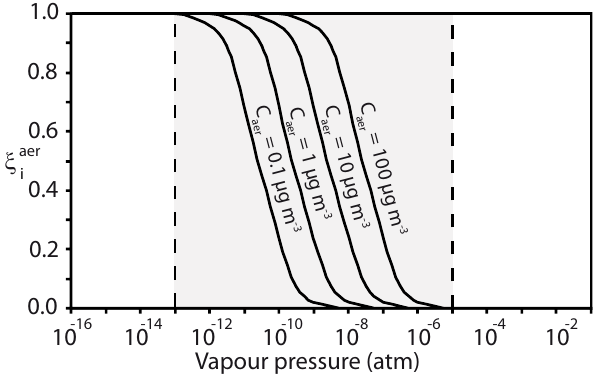
Fig. 1. Fraction ξ aer in the aerosol phase at thermodynamic equilib- i rium as a function of the saturation vapour pressure of the species considered and for typical atmospheric aerosol concentrations. The calculation is performed assuming an ideal mixture in the con- densed phase and mean molar mass of 200gmol − 1 . Shaded area represents the vapour pressure range where significant partitioning of the species may occur under atmospheric conditions at equilib-